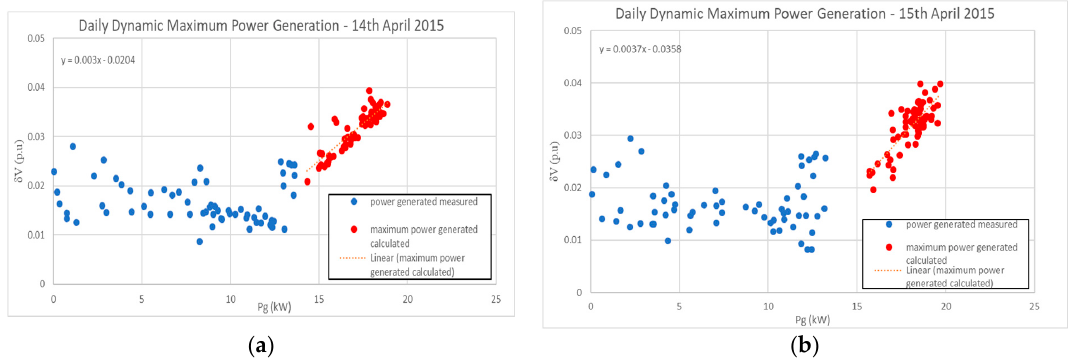
Figure 6. Voltage variation x generated power and the linear dependency in relation to the maximum amount of power calculated by Equation (5) for 12th of April 2015 and 13th of April 2015.